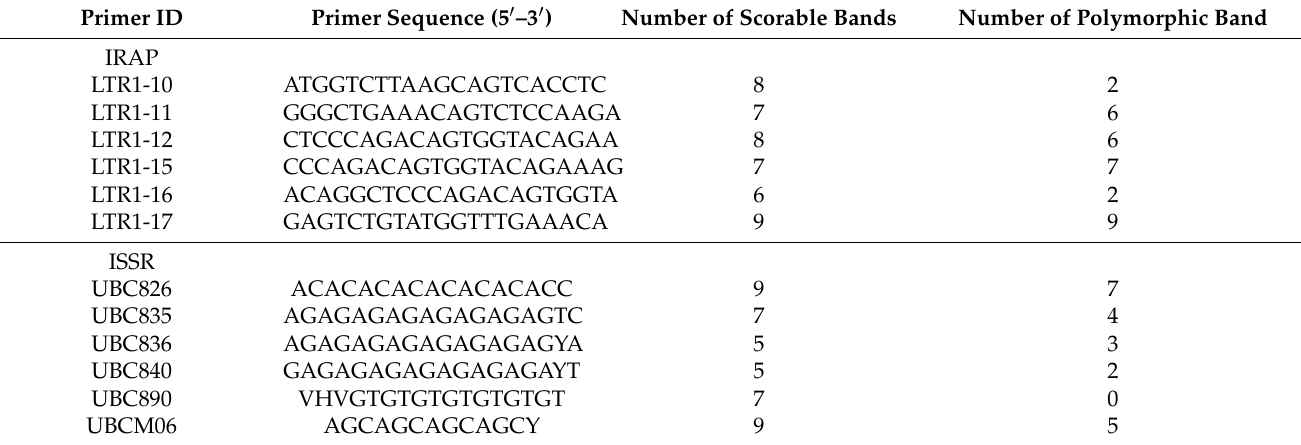
Table 3. IRAPs and ISSRs information selected to detect the genetic fidelity of R. bailiense callus. Primer